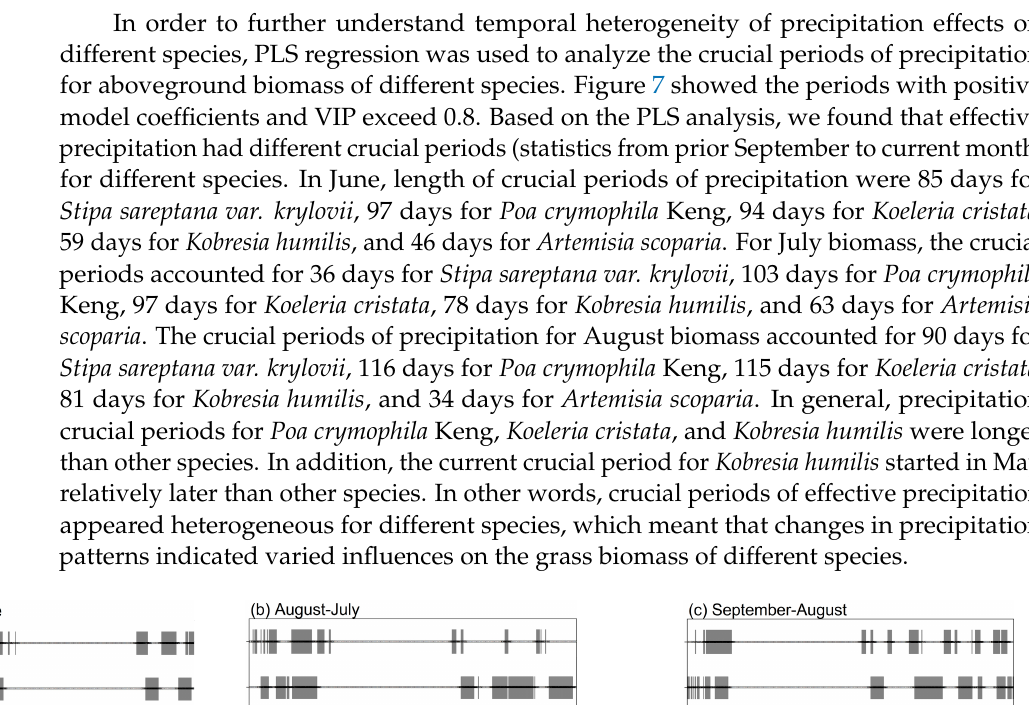
Figure 6. Results of Partial Least Squares (PLS) regression correlating grass biomass in 1997–2011 with 15-day running means of daily effective precipitation during ( a ) July–June, ( b ) August–July and ( c ) September–August. Blue bars indicate that VIP values are greater than 0.8, the threshold for variable importance. Red color means model coefficients are negative and important, while green color indicates important positive relationships between aboveground biomass and precipitation.